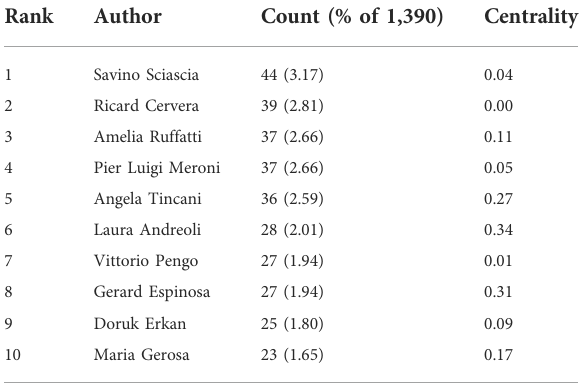
TABLE 3 Top 10 authors with the most publications involved in